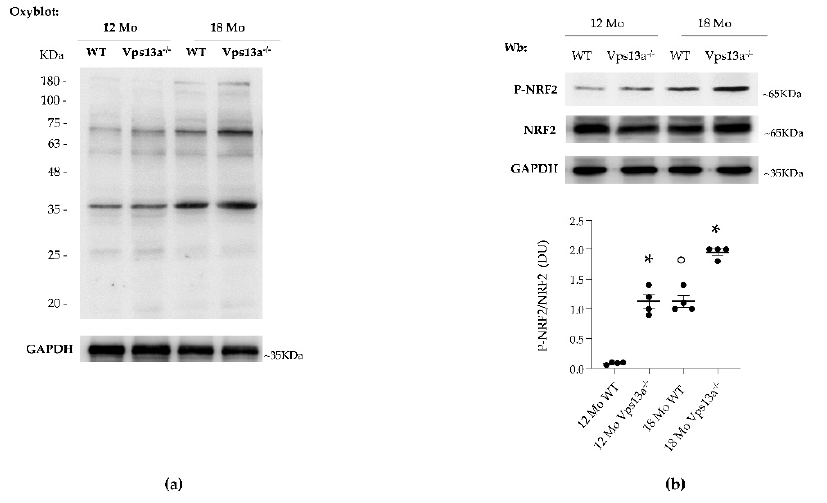
Figure 2. ( a ) Basal ganglia soluble fractions from WT and Vps13a − / − mice aged 12 and 18 months (Mo) of were analyzed on 11% SDS-PAGE and subjected to OxyBlot. Carbonylated proteins (1 mg) were detected by treating with 2,4-dinitrophenylhydrazine and blotted with anti-DNP antibody. Representative of 4 blots with similar results. Quantitation of band area is reported in Supplementary Figure S2a. ( b ) Western-blot (Wb) analysis of phospho-NRF2 and total NRF2 in isolated basal ganglia of wild-type (WT) and Vps13a − / − mice aged 12 and 18 months. GADPH was used as loading control. Representative of 4 blots with similar results. Densitometric analysis is shown in lower panel. Data are presented as means ± SEM, n = 4 * p < 0.05 compared to WT animals; ◦ p < 0.05 compared to 12-month-old WT